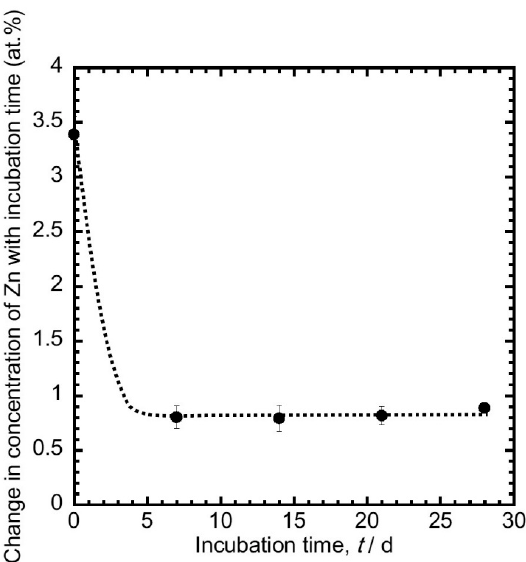
Figure 5. Change in the concentration of Zn in the oxide layer with incubation time determined by XPS ( n =